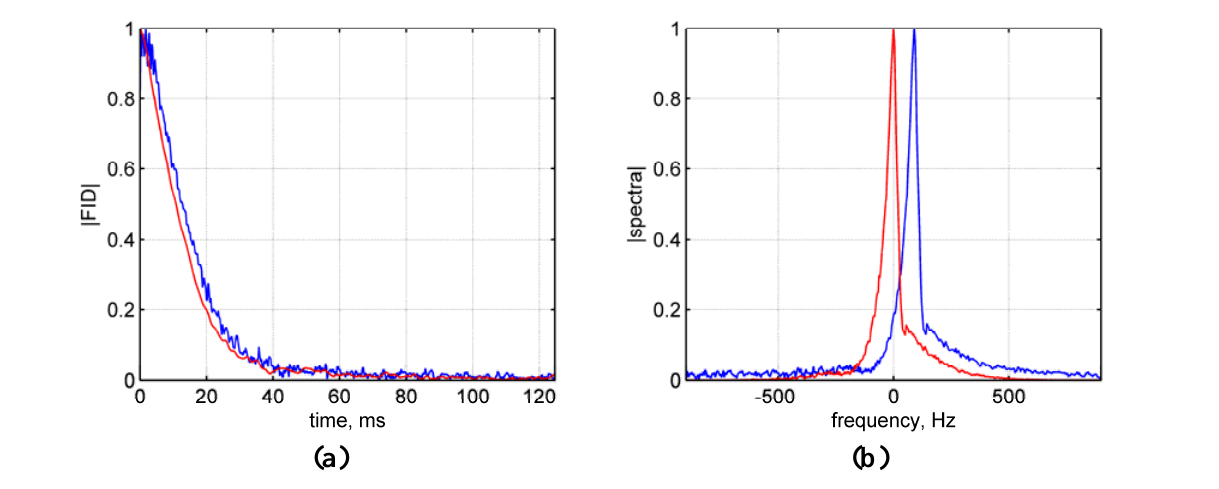
1. Figure 1, p. 1551 should be with the correct time and frequency axes: Figure 1. Spectral processing of the single voxel spectroscopic data. ( a ) Raw (blue) and processed (red) magnitude free induction decay functions (FIDs); ( b ) Raw (blue) and processed (red) magnitude spectra. Note that graphics and spectra were normalized to their maximum values for comparison purposes and the panels are scaled differently.